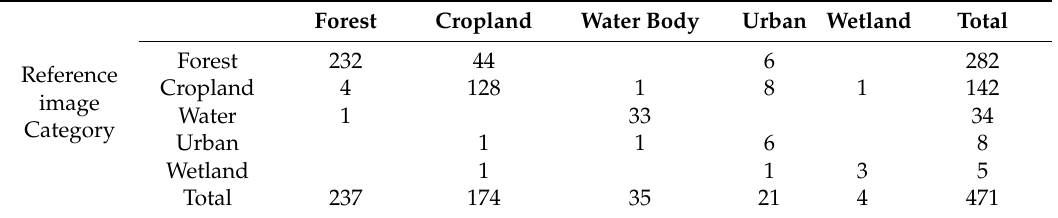
Table 12. Error matrix between classified and Google Earth images for area B.